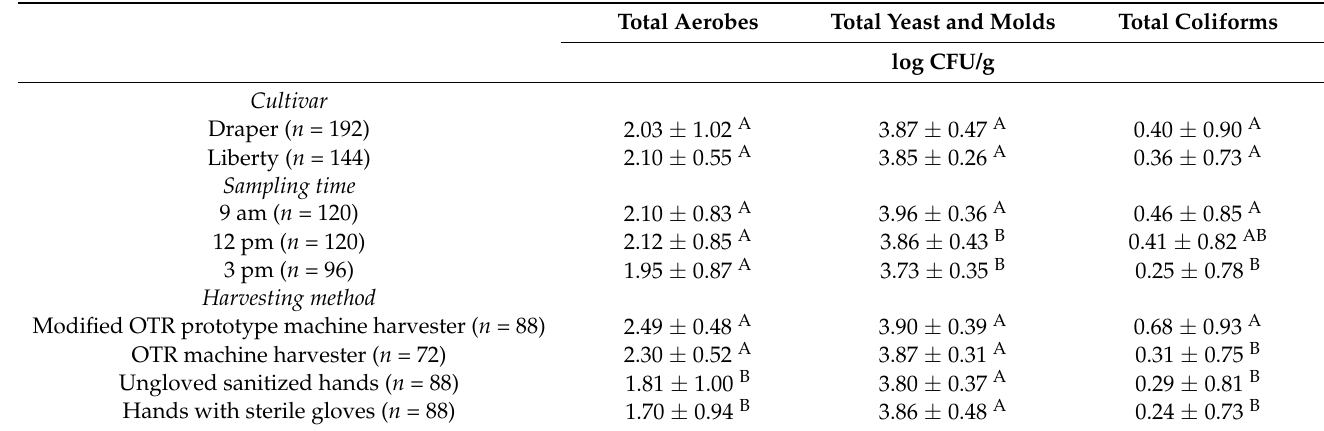
Table 2. Overall mean microbial load on the sampled fresh blueberries of various cultivars harvested using various methods at different sampling time